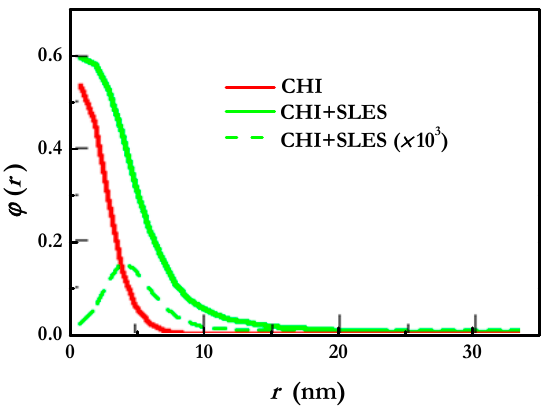
Figure 9. Density profiles analyzed perpendicularly to the surface for CHI and CHI-SLES layers, at the same concentration and ionic strength. The SLES concentration was 0.1 mM.